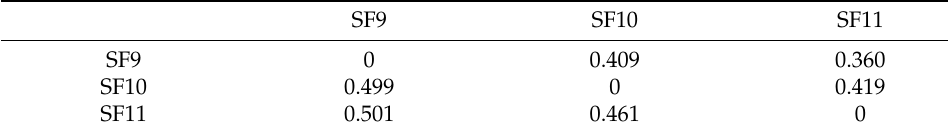
Table A5. Normalized direct-relation matrix for Adaptability sub-criteria.